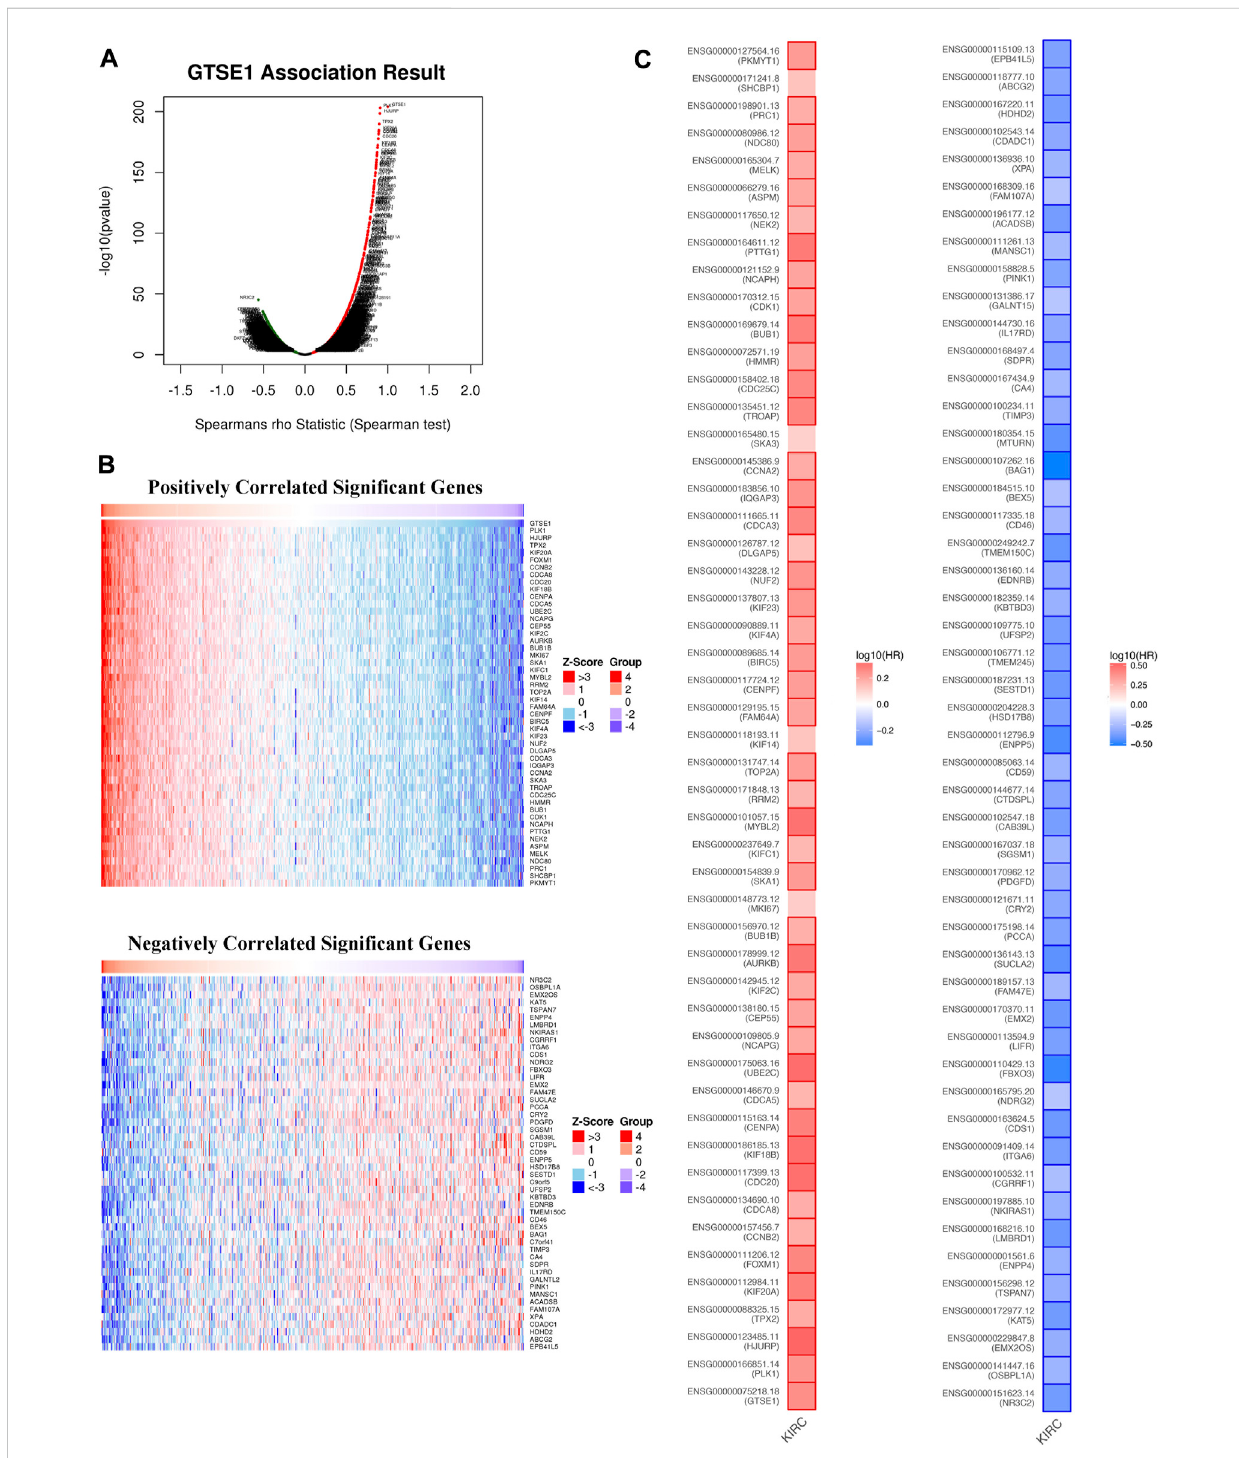
FIGURE 5 GTSE1 coexpression networksin ccRCC (LinkedOmics). (A) The volcano plot of genes highly correlated with GTSE1 based on theSpearman test. (B) Thetop50genespositivelycorrelatedornegativelycorrelatedwithGTSE1areshownintheheatmaps. (C) Theoverallsurvivalanalysisofthetop50genes positively correlated or negatively correlated with GTSE1 is also displayed in the survival